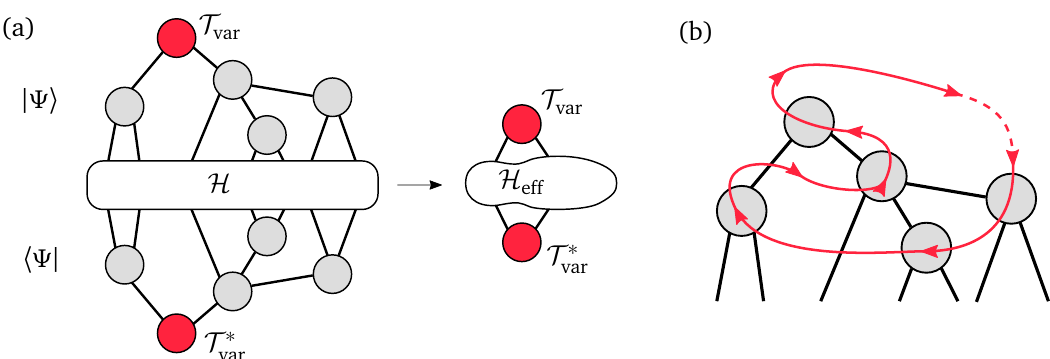
Figure 34: Basic idea of the variational ground state search: (a) In order to reduce the complexity of the minimization problem, only the parameters of one tensor T (red) are taken as variational while all other tensors are taken as fixed. The var variational tensor forms the “optimization center", while the fixed tensors form an “environment". The latter can be efficiently contracted with the Hamiltonian H , leading to a reduced “effective" Hamiltonian H . (b) By solving the reduced optimization eff problem sequentially (for varying locations of the optimization center), the energy expectation value is gradually reduced. This iterative minimization is commonly called